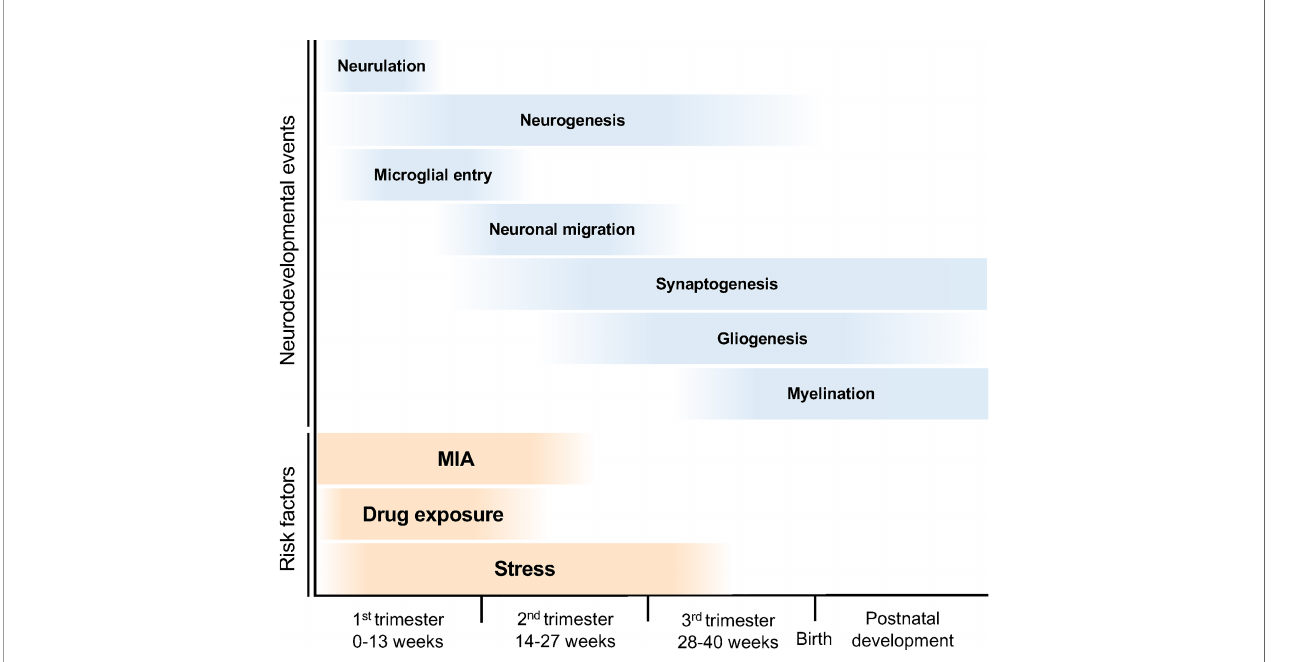
FIGURE 2 | Neurodevelopmental trajectory and risk factors for NDDs. The blue bars indicate neurodevelopmental events during fetal brain development. After neural tube formation in the ectoderm (neurulation), brain vesicles are formed and neuroepithelial cells produce neural stem cell progenitors and neurons (neurogenesis). Neural progenitor cells also produce astrocytes and oligodendrocytes (gliogenesis). The developing neurons migrate, differentiate into speci fi c subtypes, and form synapses and myelin. The orange bars indicate the risk periods for NDDs. MIA during pregnancy can cause NDDs; in particular, the risk of ASD onset increases in the fi rst half of pregnancy. Maternal stress and drug exposure during pregnancy can also cause NDDs. For example, thalidomide and valproic acid exposure are known risk factors for ASD